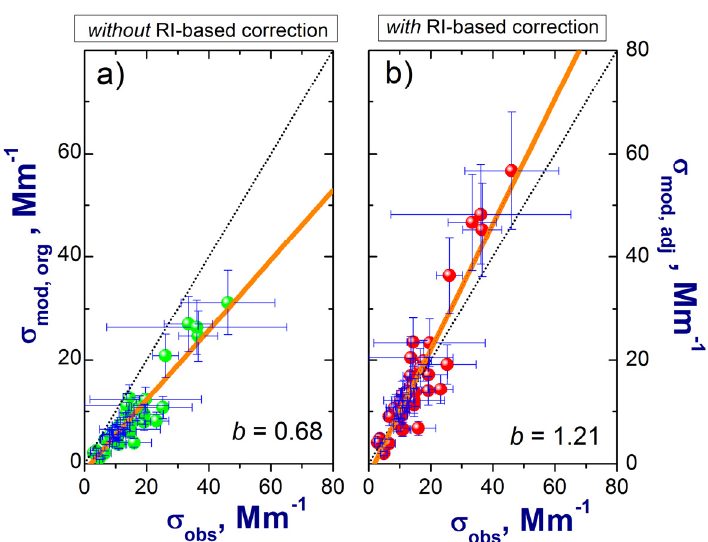
Figure 9. Comparison of the ambient total scattering observed ( σ obs ) with ambient total scattering calculated ( σ mod ) for the original ( a ) and adjusted ( b ) size distributions at 0.55 µm wavelength for all TCAP FLs. Here b is the slope of the linear regression fits to the data (straight orange lines). Error bars represent uncertainties of measured (Section 3) and calculated (Section 4.4) scattering